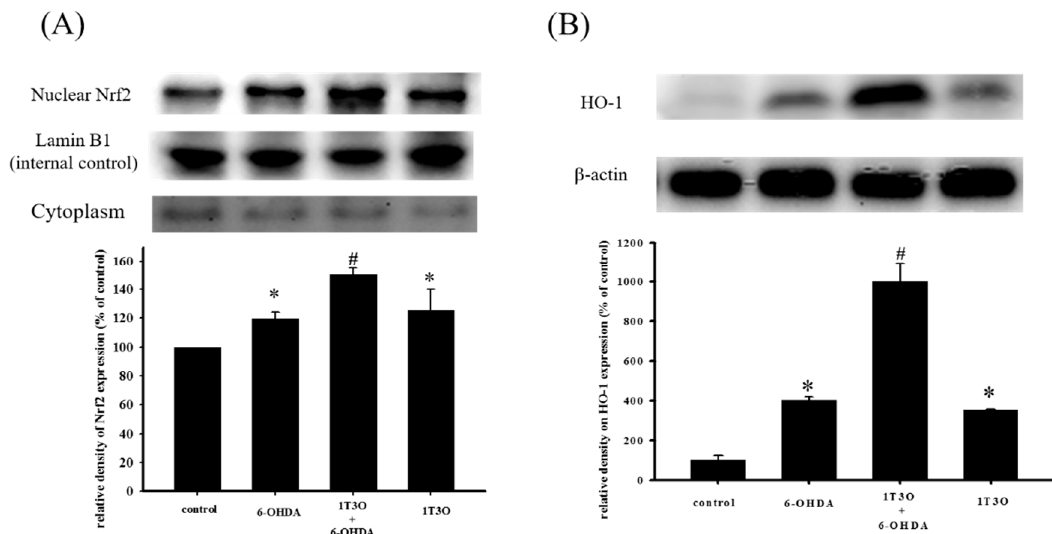
Figure 8. Effect of 1T3O on 6-OHDA-induced increase in intra-nuclear transcription factor Nrf2 and HO-1 expression. Western blot was used to quantitate the expression of intra-nuclear Nrf2 and HO-1, and the effect of 1T3O (1 μ M) on 6-OHDA (20 μ M)-induced increase in Nrf2 ( A ) and HO-1 ( B ) expression. 1T3O significantly increased 6-OHDA-induced elevation in intra-nuclear Nrf2 and HO-1 expression levels. Data were presented as mean ± SEM. (* p < 0.05 vs. Control; # p < 0.05 vs. 6-OHDA group)